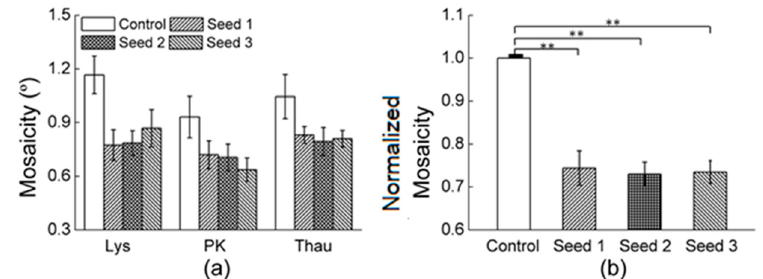
Figure 3. One-way ANOVA analysis on the mosaicity, with the error bars showing the standard error of the mean. ( a ) A comparison of the mosaicities of the protein crystals obtained in the presence and absence of CLPC seeds, ( b ). Averaged normalized mosaicities in the presence and absence of CLPC seeds. ( ** represents saliency). In terms of the mosaicity of the protein crystals, the results showed that there were significant differences between the control group and other groups. (n = 3, P < 0.05). Crystals with seeds showed a better mosaicity. B-factor (cid:79) B-factor 3 B-factor